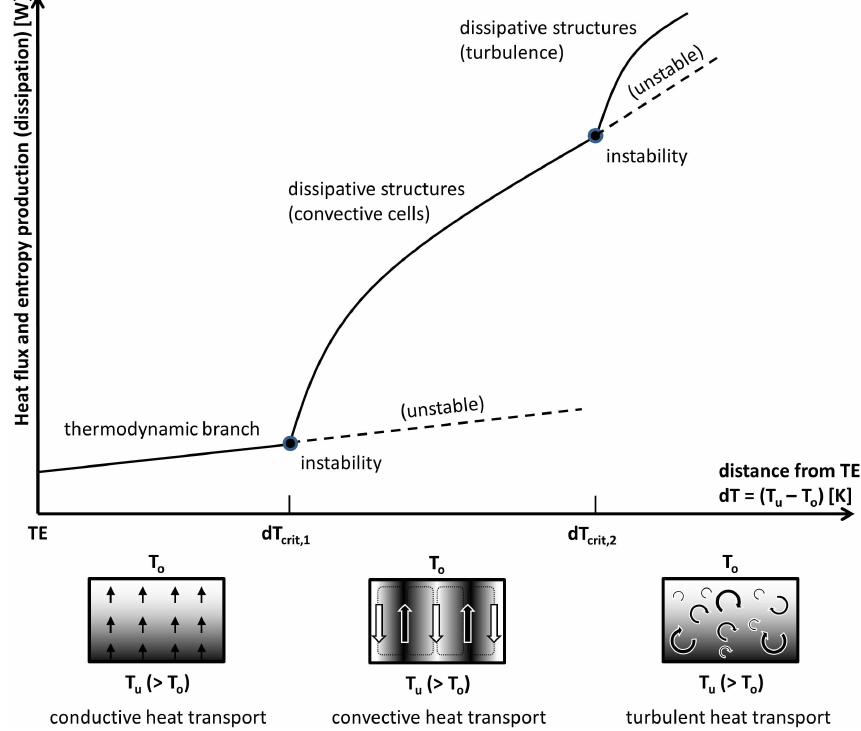
Fig. 1. Highly simplified sketch of steady-state heat transport and entropy production (dissipation) in a reservoir heated at the bottom, as a function of distance from thermodynamic equilibrium (TE). The distance from TE is expressed by the temperature difference between bottom and top. Beyond a critical distance from TE, self-organization creates macroscopic structure (convective cells, turbulence), accelerating the heat flux from bottom to